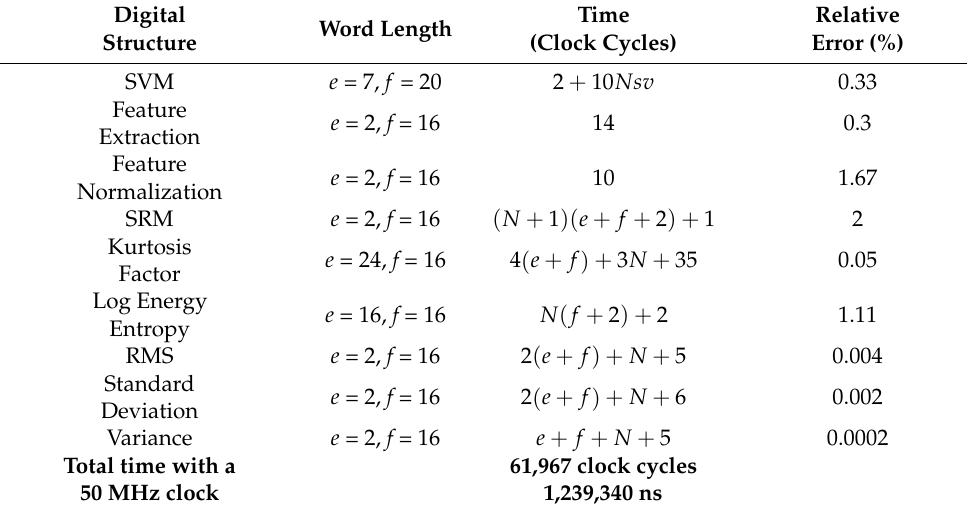
Table 4. Time and relative error from each processing